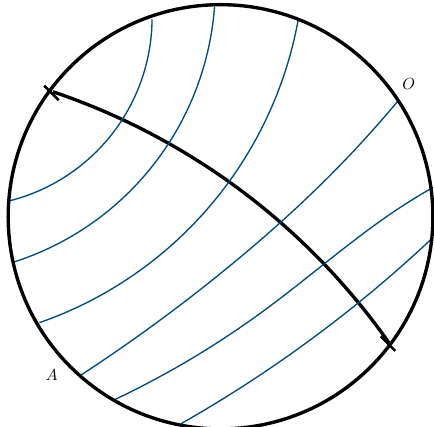
Figure 1 . The RT surface m A along with a maximal configuration of bit threads. The area of m A and the number of bit threads both calculate the holographic entanglement entropy S